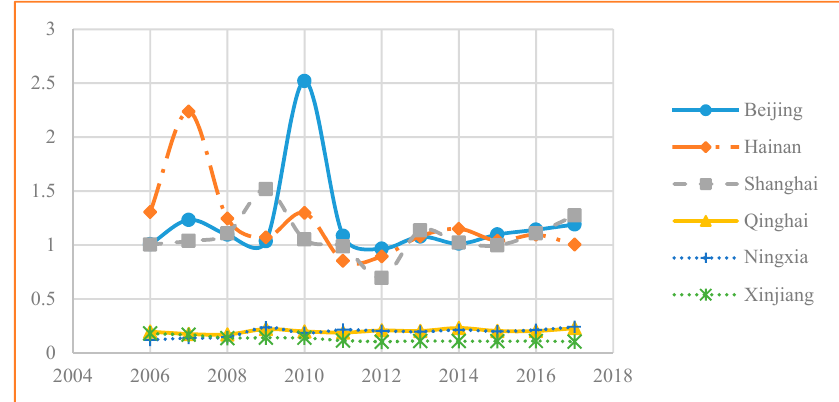
Figure 2. Top and bottom three EWP performers between 2006 and 2017.